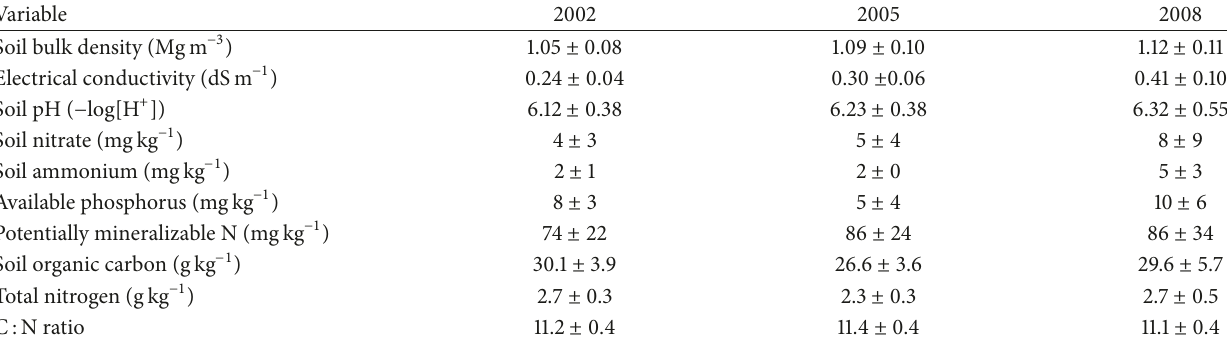
Table 3: Mean values ( ± 1 standard deviation) for soil properties in 2002, 2005, and 2008.